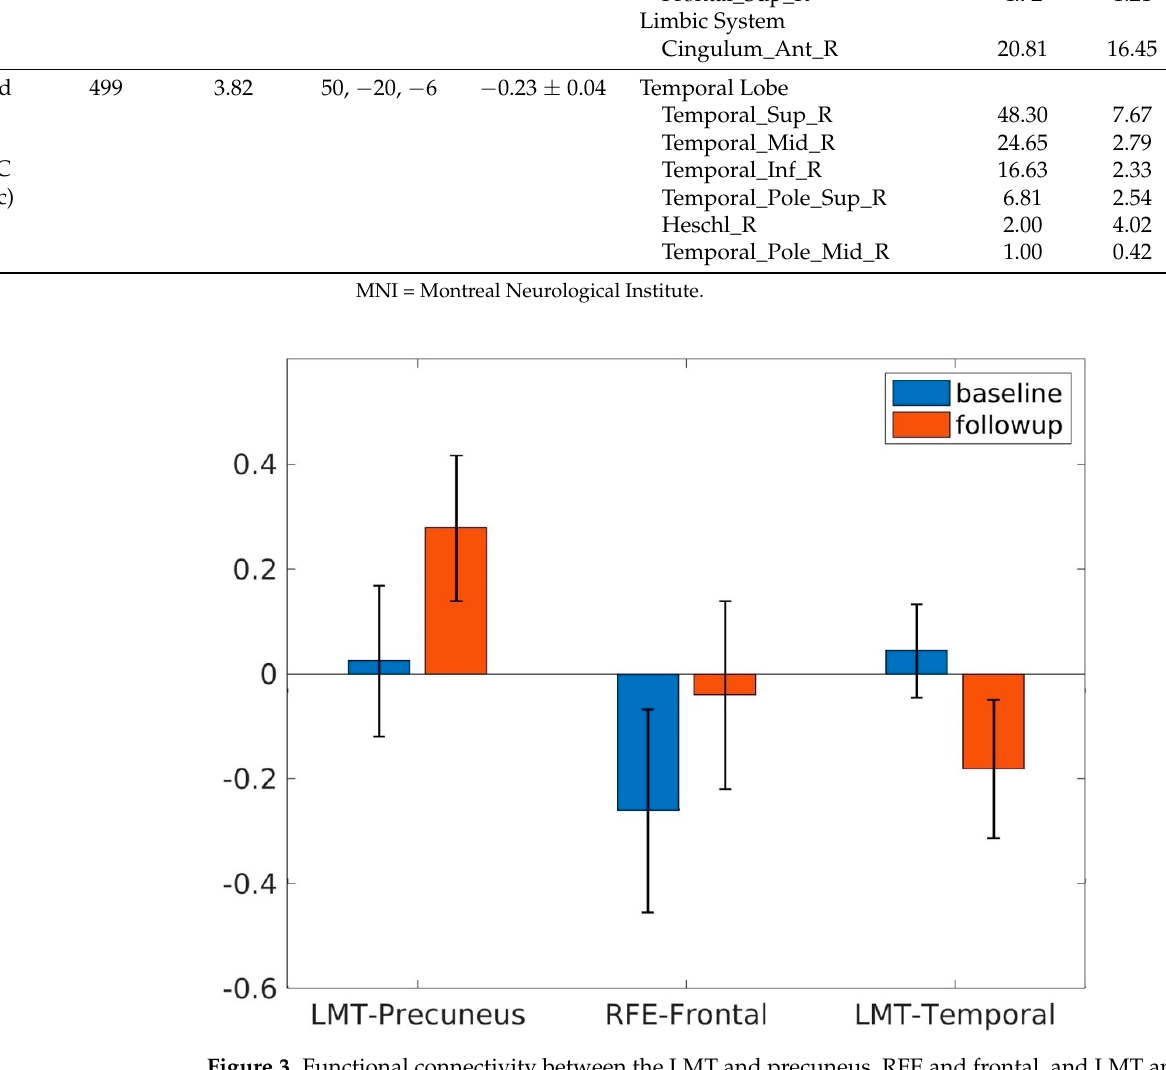
Figure 3. Functional connectivity between the LMT and precuneus, RFE and frontal, and LMT and temporal regions at baseline and follow-up.